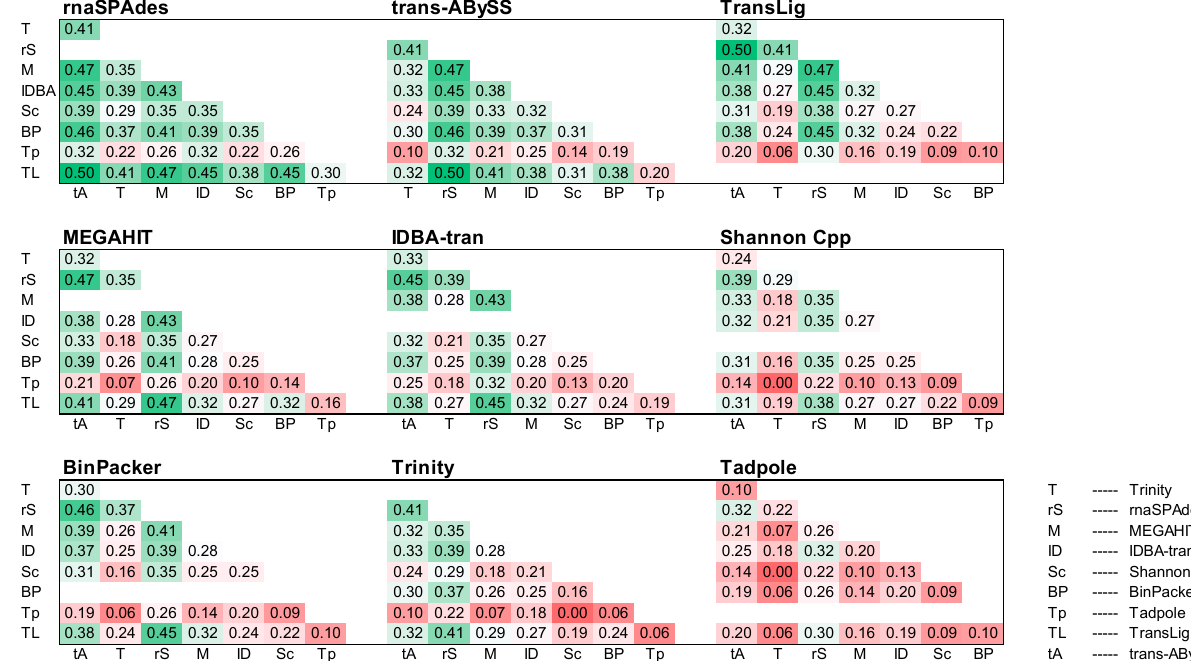
Figure 5. Tri-assembly Scores. Tri-assembly assessment score results from 84 combinations of 9 assemblers, respectively. All assembler metrics are compared to over/underperformance to the average MEGAHIT single-assembly score. Highlighted values range from high average assembly scores up to 0.5 (green) to low average assessment scores down to 0.0 (red). Metric scores are consistent, with previous figures allowing for cross comparison.